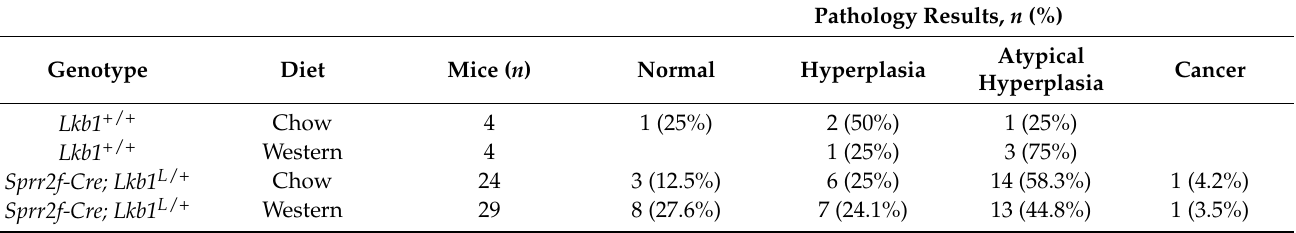
Table 2. Mouse uterine